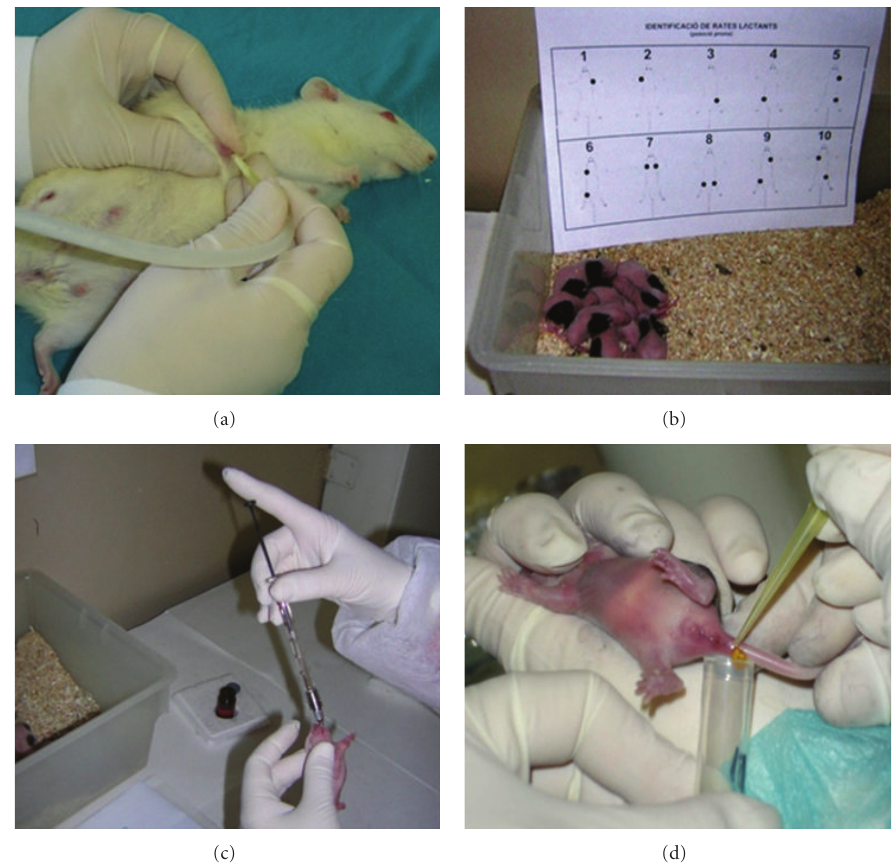
Figure 4: Images showing dam and o ff spring handling. (a) Milk from dams is collected by using elastic tubing connected to a gentle suction. (b) Animal identification by labeling the animals with a marker pen on the skin. (c) Oral gavaging in newborns younger than 5 days with ophthalmic 23-gauge gavage tubes and a short-volume syringe. (d) Example of noninvasive sampling (feces) from a neonatal